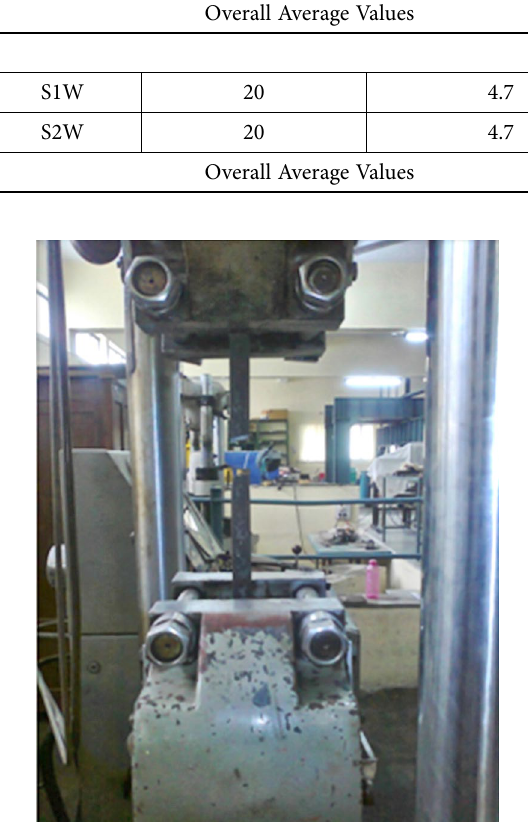
All dimensions are in mm Indicates positions of dial